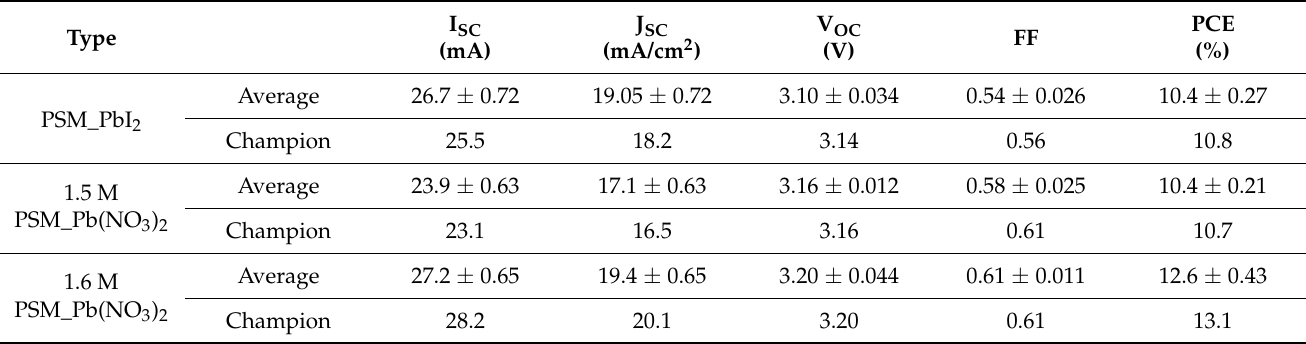
Table 4. Photovoltaic parameter of PSM_PbI 2 , 1.5 M and 1.6 M PSM_Pb(NO 3 ) 2 two step dipp- ing